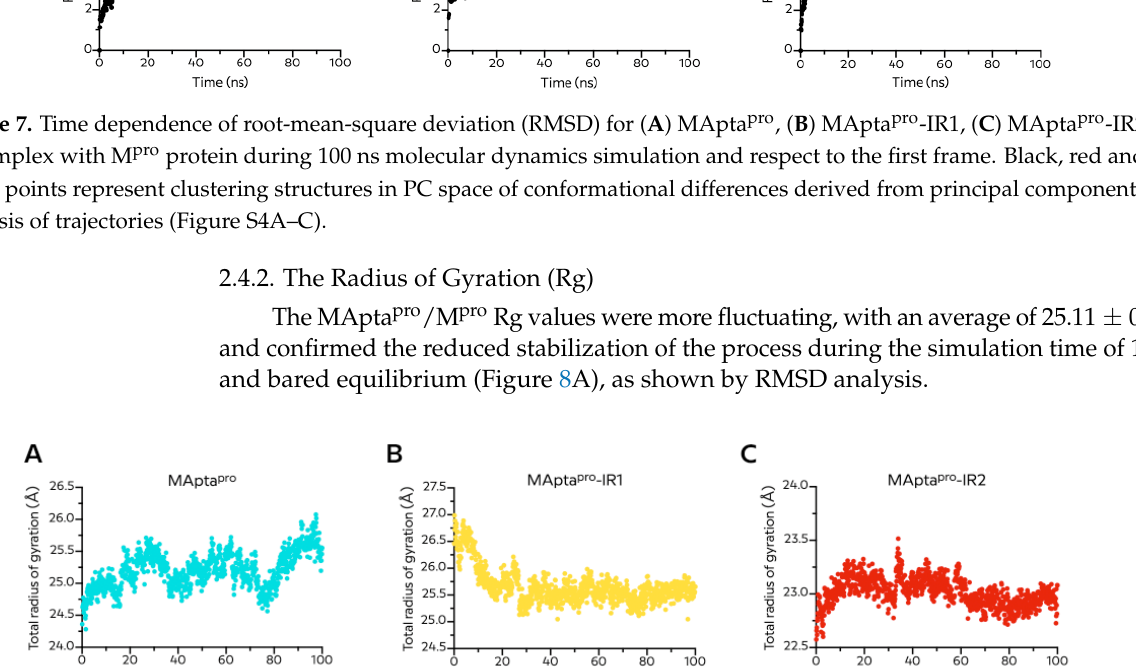
Figure 7. Time dependence of root-mean-square deviation (RMSD) for ( A ) MApta pro , ( B ) MApta pro - IR1, ( C ) MApta pro -IR2 in complex with M pro protein during 100 ns molecular dynamics simulation and respect to the first frame. Black, red and green points represent clustering structures in PC space of conformational differences derived from principal components analysis of trajectories (Figure S4A–C).